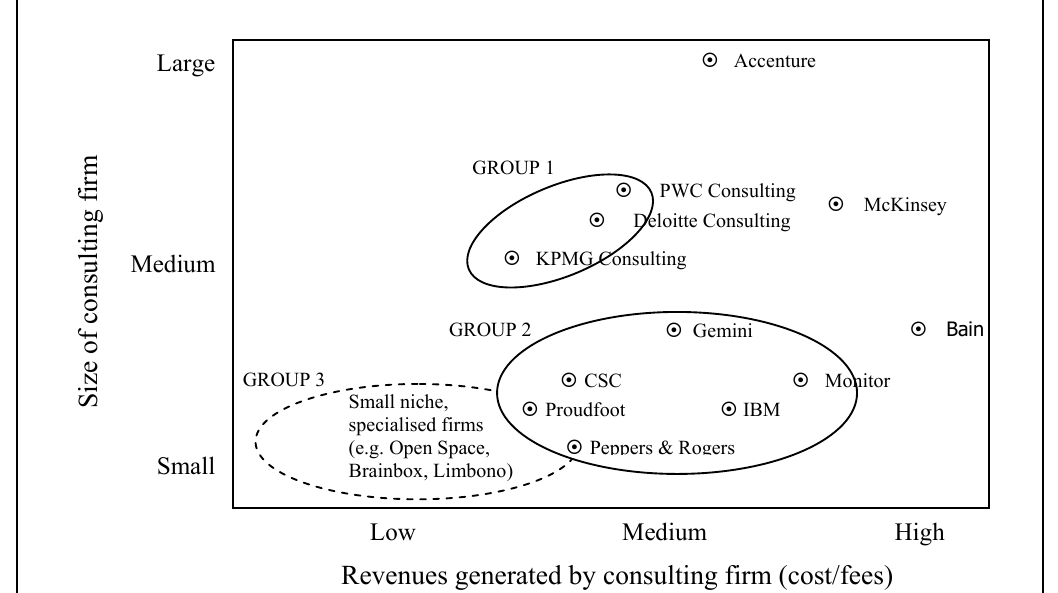
Figure 1; Strategic map of South African consulting